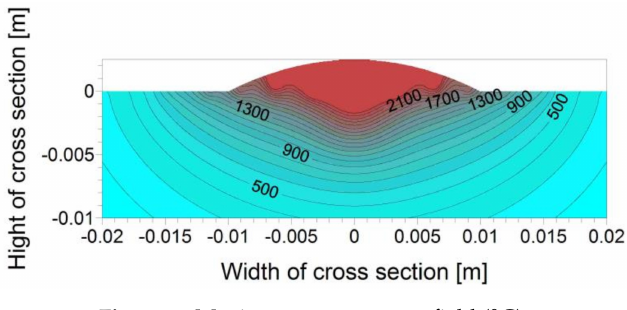
Figure 6. Maximum temperature field ( ◦ C).